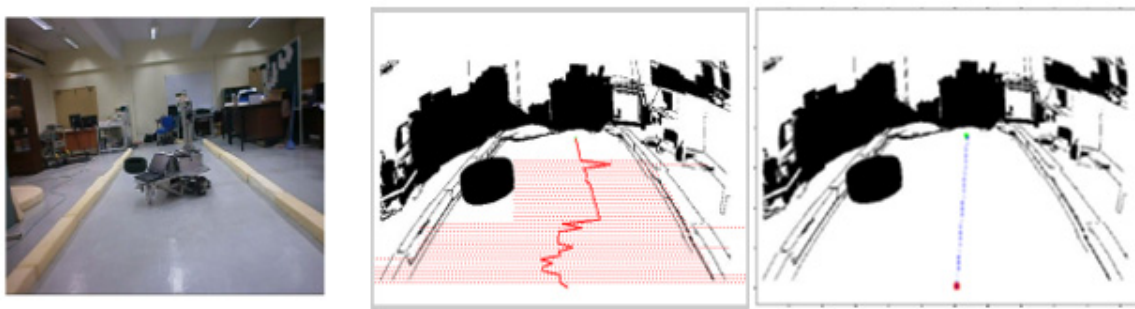
Figure 15. Comparison between GLS and LS in indoor environment: ( a ) search time, ( b ) distance. 4.2.2. Outdoor Results A mobile robot was operated in a complex outside roads with partial maps where it was required to deal with unexpected obstacles spotted along the way. In these situations, the GLS-based path-planning algorithm must be able to handle path planning in such a partial environment and employ efficient representations. The GLS algorithm has been implemented on a real road at the University Malaysia Pahang Pekan campus, as shown in Figure 16a. The image processing algorithm enables the robot to find the borders of the roads and obstacles, with capability to eliminate the other parts of the road, as shown in Figure 16b. From Figure 16c, it can also be seen that the algorithm can effectively traverse the outdoor environment.